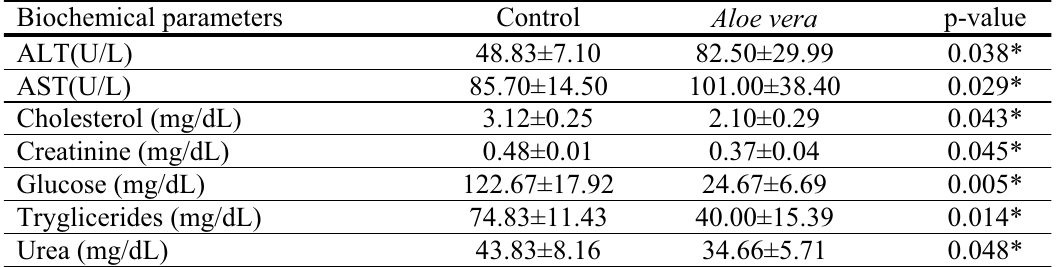
TABLE 2 - Effect of aqueous extract of Aloe vera on biochemical parameters from Wistar rats